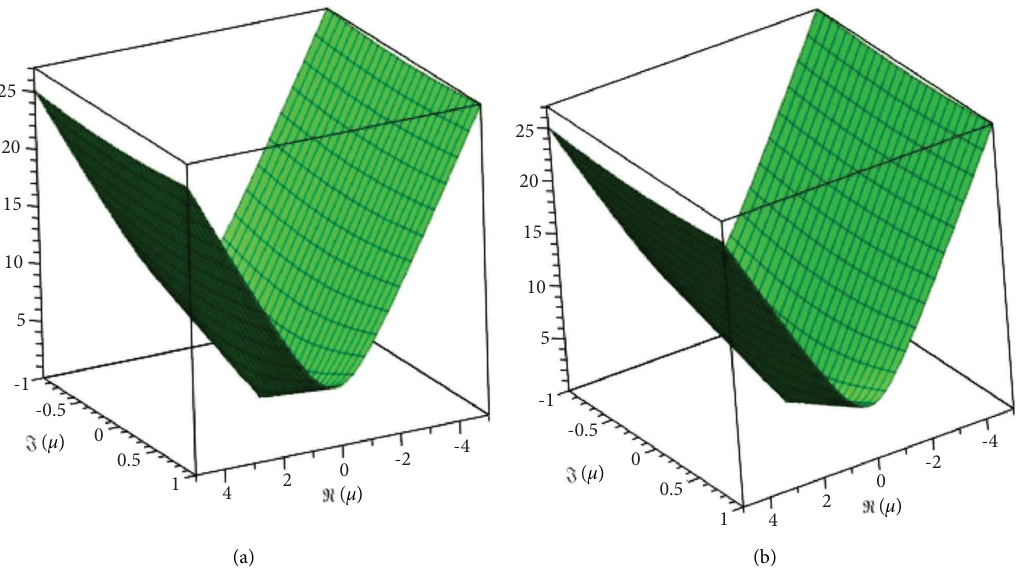
Figure 9: For varying Z and η values, the life-threatening cases are increasing fastly (a) F